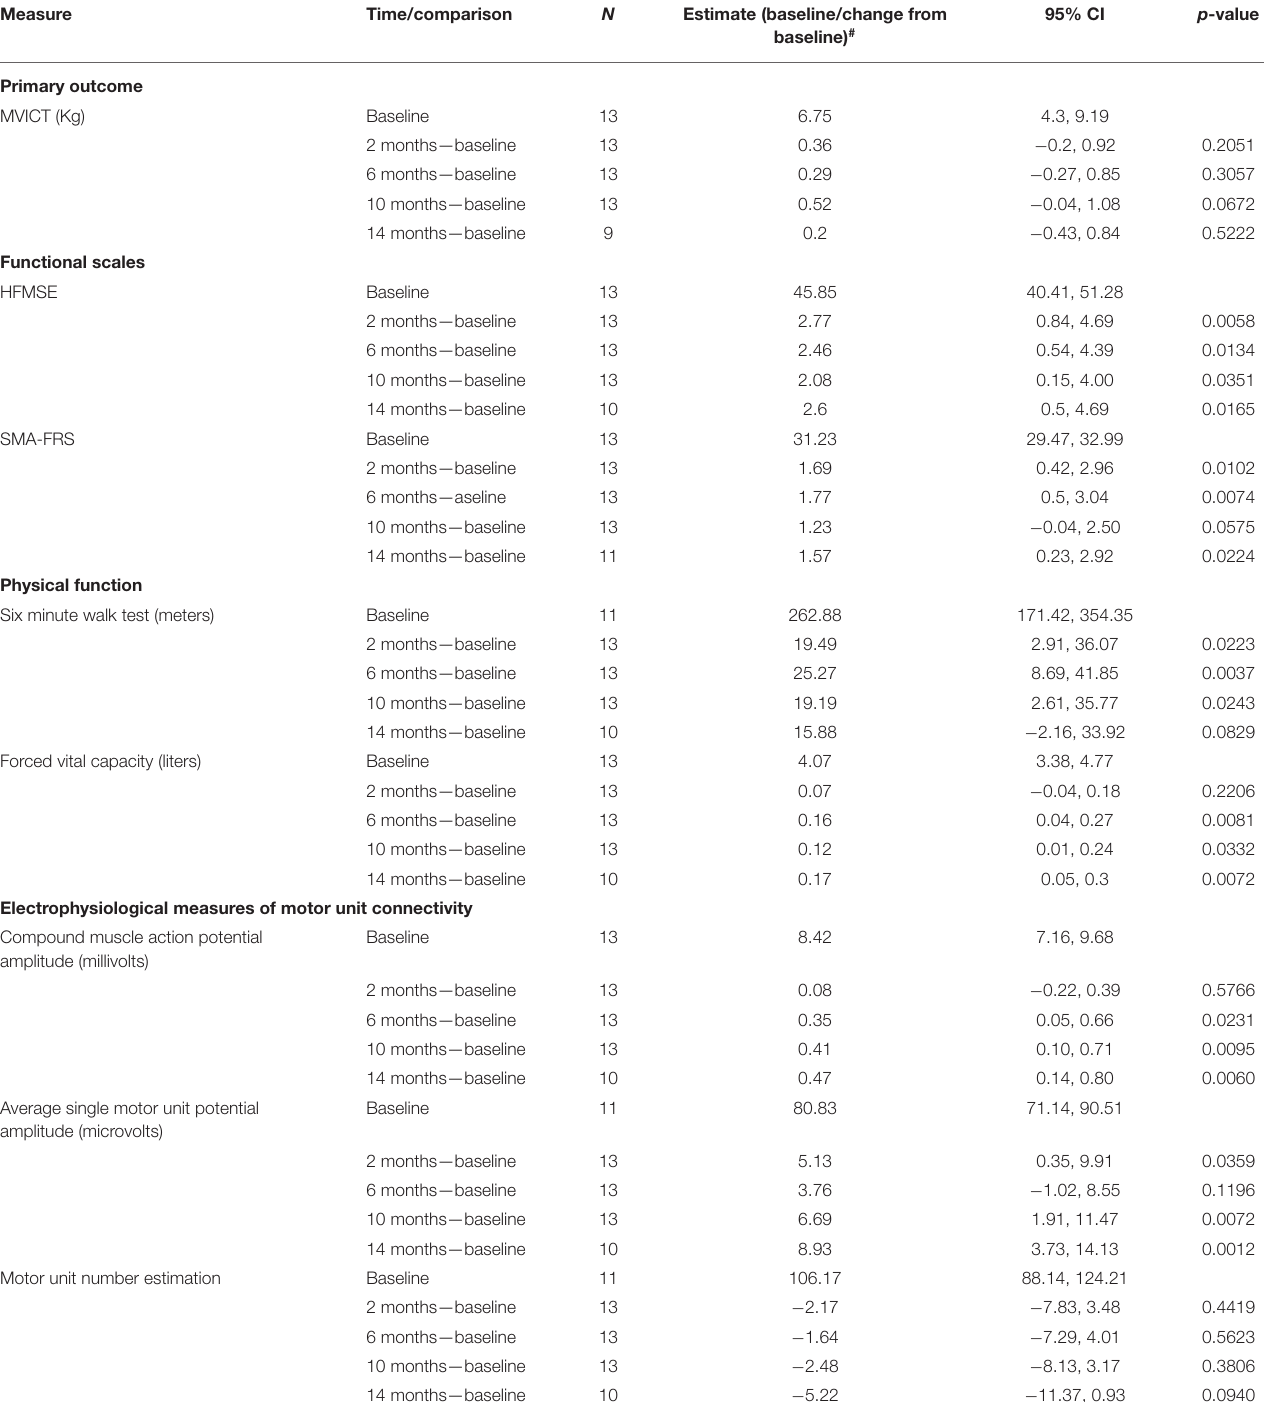
TABLE 2 | Longitudinal change of prospective outcomes following nusinersen treatment. Measure Time/comparison N Estimate (baseline/change from